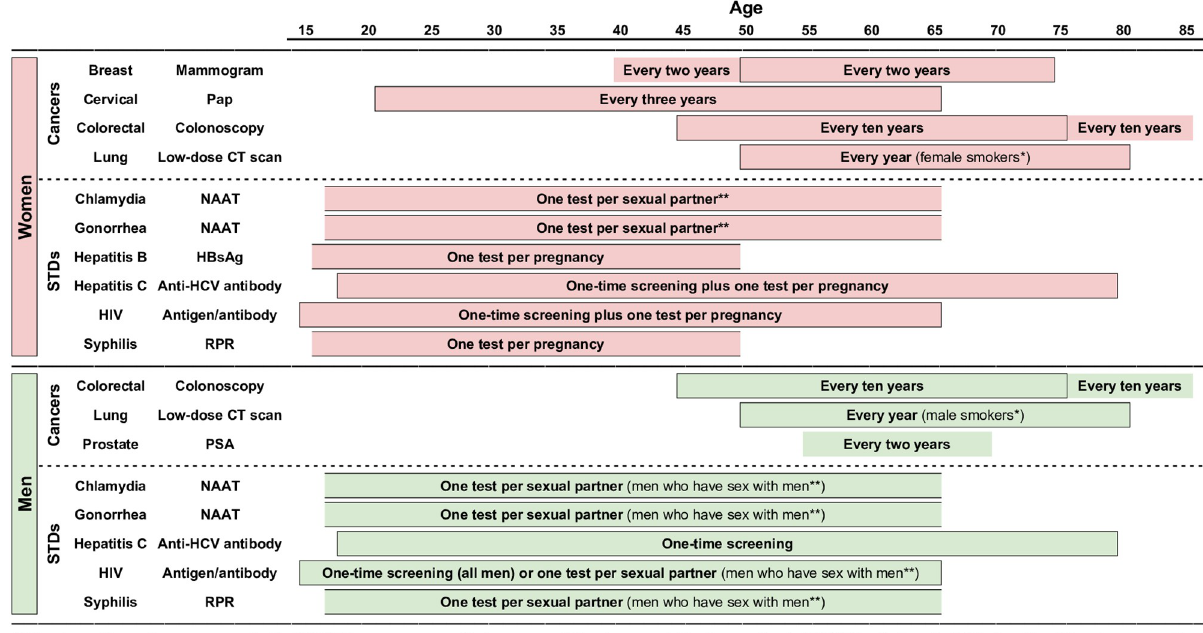
Fig 1. Timeline of screening